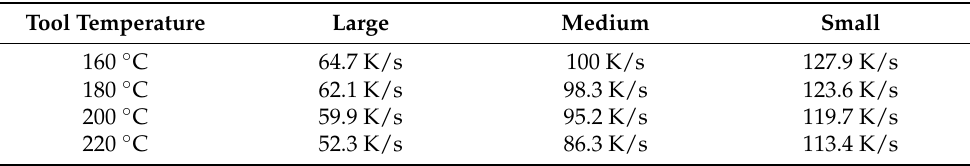
Table 2. Cooling rates defined by simulations according to specimen size (in correlation with casting wall thickness) and set tool temperature.